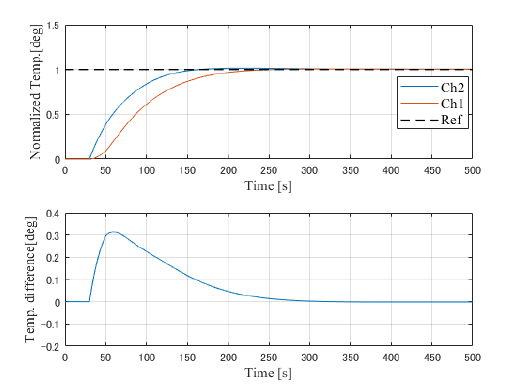
Figure 11. SMBC with Smith predictor compensation.